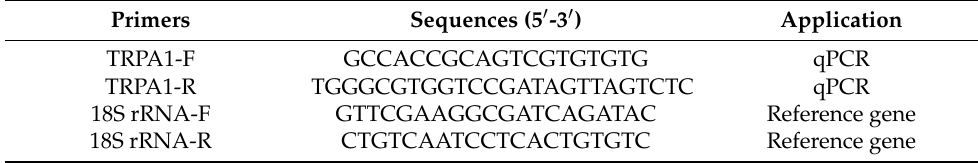
Table 1. PCR primers used in this study